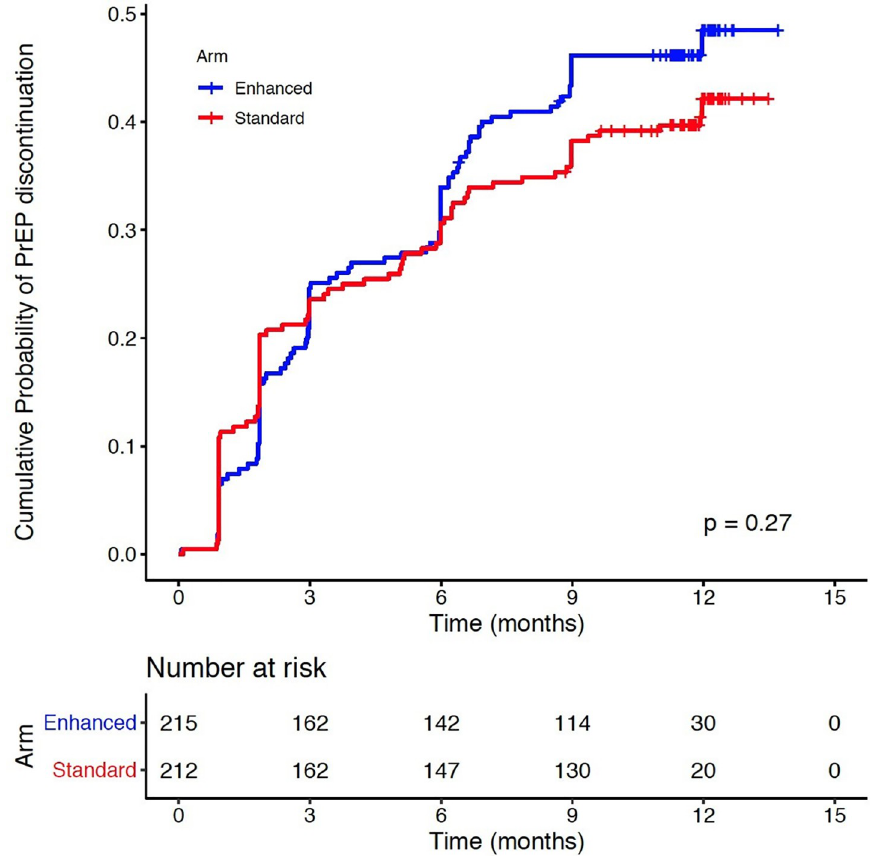
Fig 3. The Kaplan–Meier curve depicts time to first PrEP discontinuation due to (1) clinician- and participant- initiated PrEP discontinuations � 30 days; or (2) a missed scheduled visit (assuming that all pills were used by the date of first missed scheduled study visit). Participants were censored at the time of HIV seroconversion or at the date of the last study visit. PrEP, pre-exposure prophylaxis.